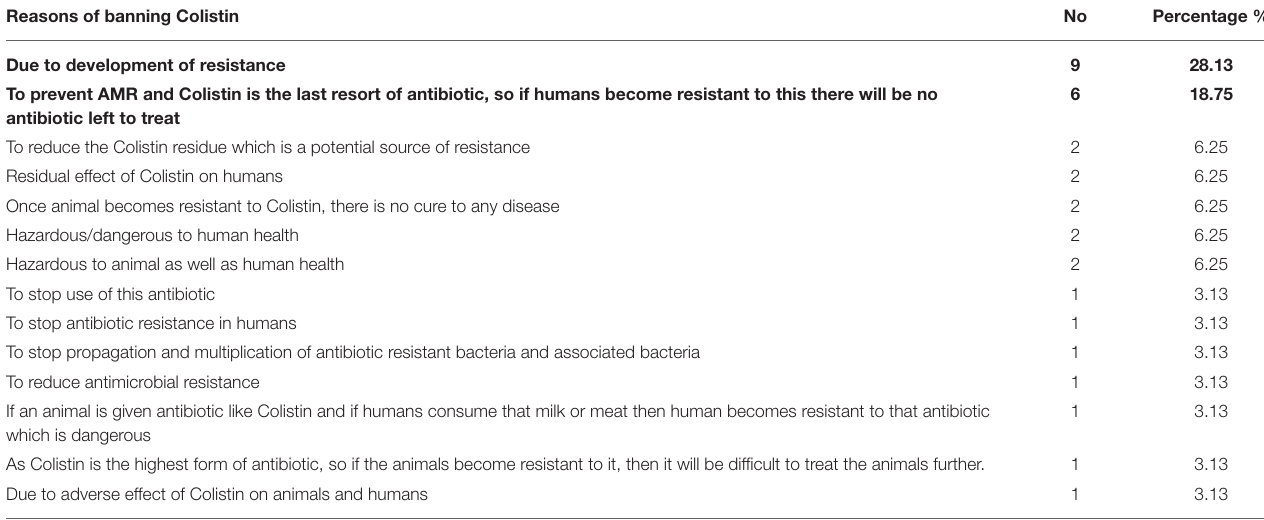
TABLE 4 | Veterinarians’ opinions for the reasons for the ban on Colistin use for animals in India. Reasons of banning Colistin No Due to development of